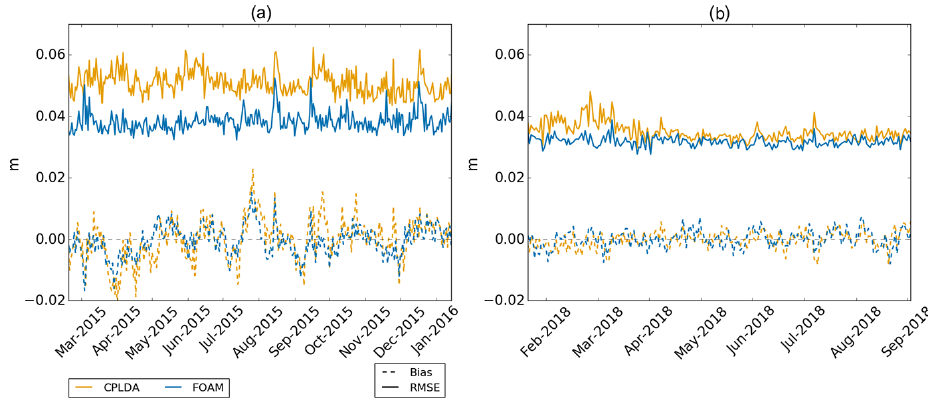
Figure 1. SLA class 4 statistics with respect to the CMEMS satellite product (Jason2, CryoSat-2 and AltiKa) for CPLDA and FOAM. (a) For the long CPLDA experiment in 2015 with the old scheduling. (b) From the operational systems for 2018; the CPLDA scheduling was updated to allow more observations to be assimilated in April 2018.